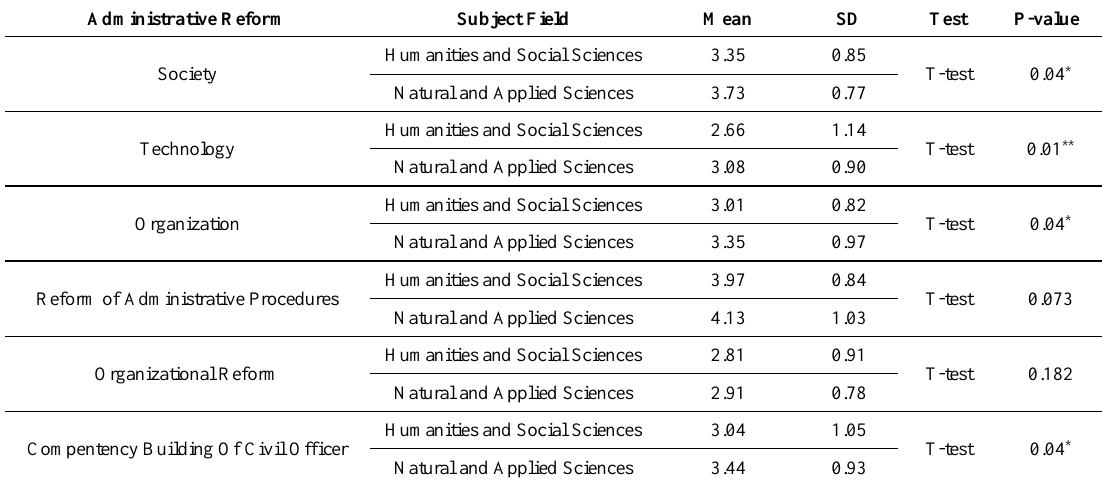
Table 8. Digital transformation and administrative reform under Subject Field variables (N=321) Administrative